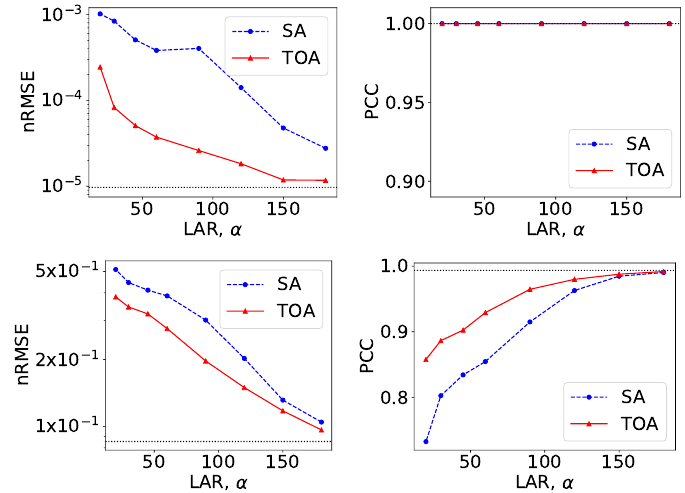
Figure 5. Metrics nRMSE and PCC, computed over VMIs of the chest phantom from noiseless data in Figure 4 (row 1) and those from noisy data in Figure 7 (row 2) as functions of LARs α τ for SA (blue, dashed) and TOA (red, solid) scans. The horizontal lines (black, dotted) indicate the reference values from FAR data of 360 ◦ .